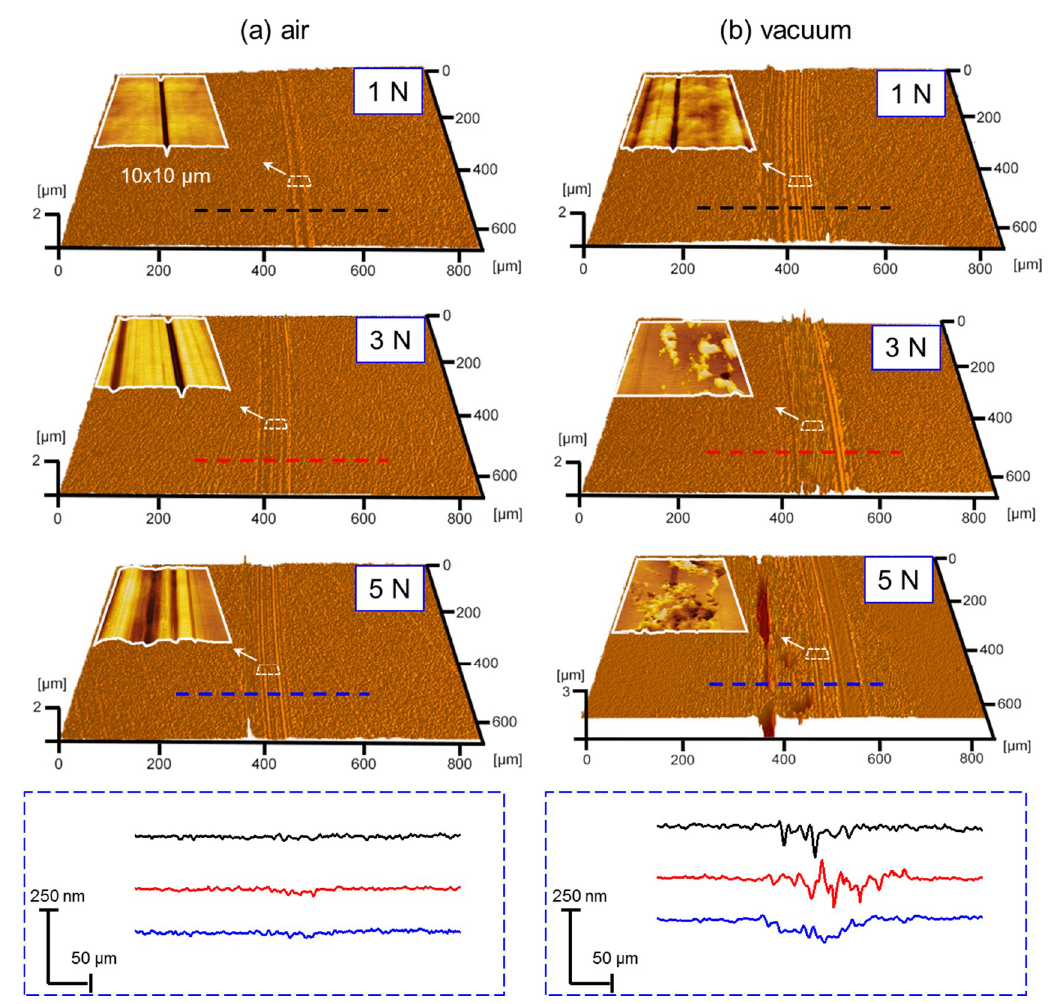
Figure 3. Three-dimensional images and corresponding cross-section profiles of wear tracks on H-DLC films formed at different normal loads in ( a ) humid air and ( b ) vacuum. Upper-left inset in each topographical picture shows AFM image inside wear track with scan area of 10 × 10 µ